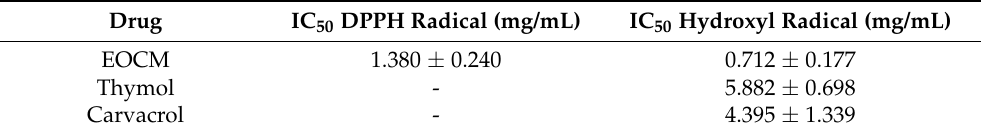
Table 3. Antioxidant activity of EOCM, Thymol and Carvacrol.